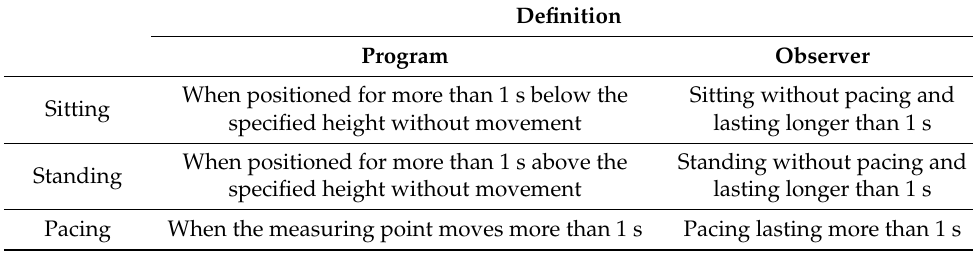
Figure 5. ( a ) Camera and computer system setting in the experiment: the camera was installed above the home cage and the number and during of the three behaviors were measured using the automate program. ( b ) User interface for the automated behavioral pattern analysis program. Table 1. Ethogram (definition of